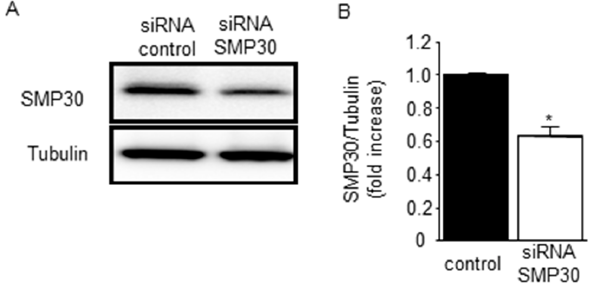
Figure 4. Transfection with siRNA targeting SMP30 in cardiomyocytes: ( A ) nonspecific control siRNA or siRNA targeting SMP30 were transfected into neonatal rat cardiomyocytes, and SMP30 expression was analyzed by Western blotting; ( B ) Expression of SMP30 was knocked down by its siRNA. Data are represented as mean ± SE ( n = 4), * p < 0.05 vs. control siRNA group. To confirm the effect of SMP30 silencing on Akt and GSK-3 β phosphorylation, neonatal cardiomyocytes were subjected to hydrogen peroxide (H 2 O 2) stimulation. Phosphorylation of ERK1/2, Akt, and GSK-3 β were increased after 1 h of H 2 O 2 stimulation. SMP30 silencing